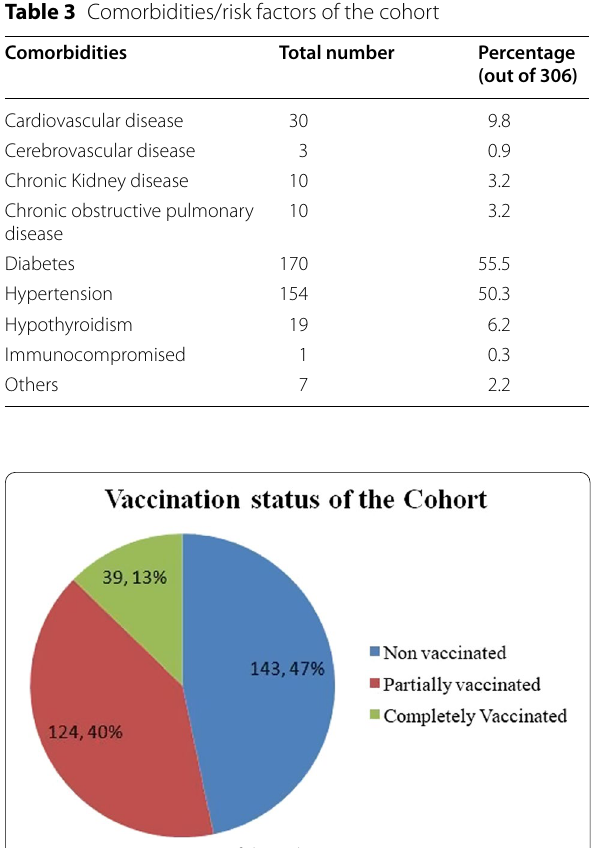
Fig. 1 Vaccination status of the